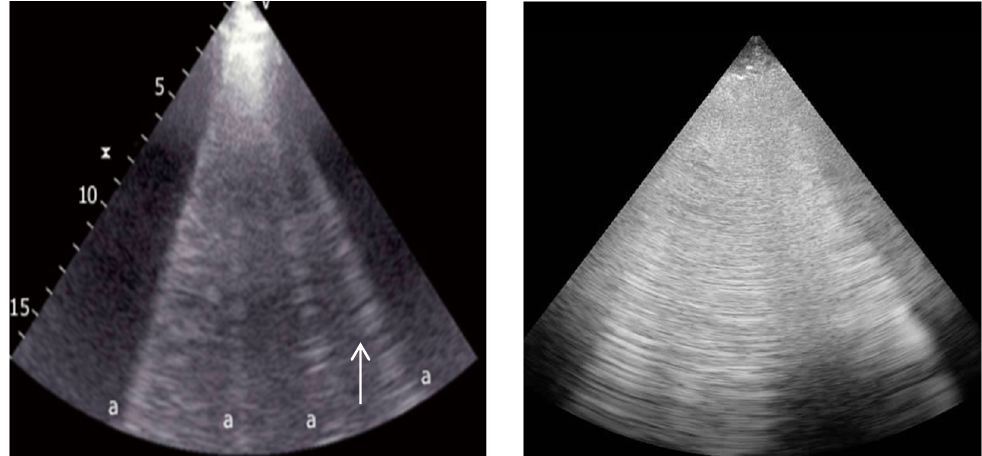
Figure 4. B-lines ( left , indicated by arrow) and “B-pattern” ( right ).